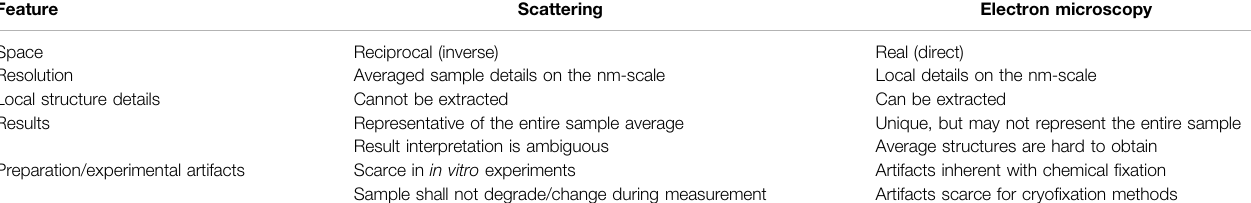
TABLE 3 | Comparison of scattering and microscopy techniques (Schnablegger and Singh, 2013). Feature